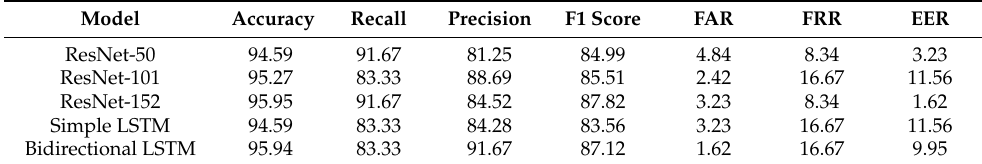
Table 4. Performance of user authentication in the smartphone manipulation scenario (Experiment 2).